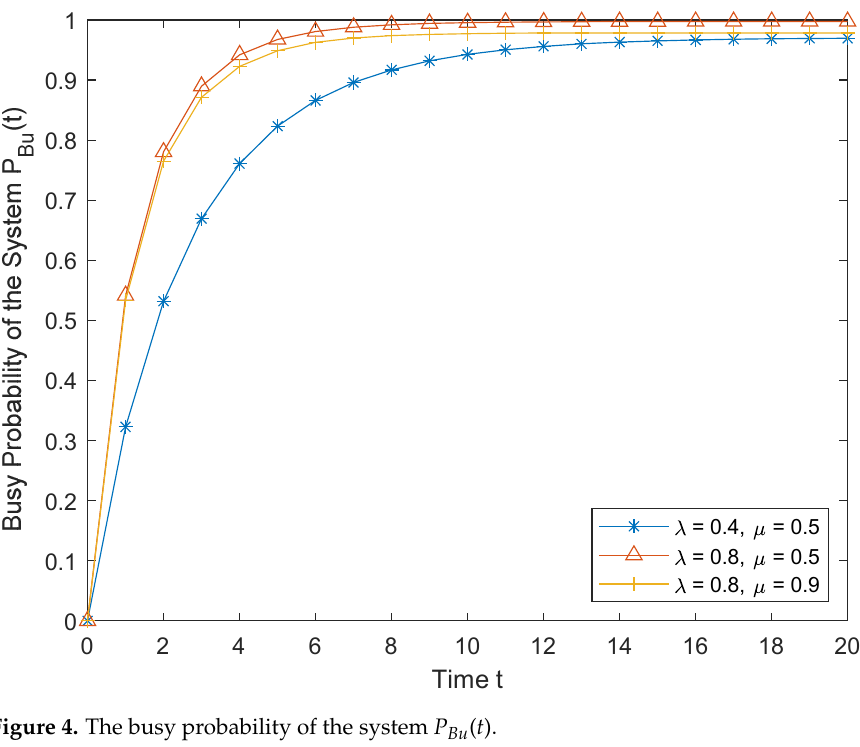
Figure 4. The busy probability of the system P Bu ( t ).